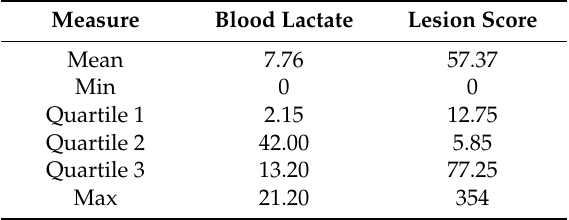
Table 1. Descriptive statistics regarding measures of relative change in lesions (number of lesions per pig) and blood lactate (mmol/L) following the fight, compared to before the fight, for the dataset ( n =